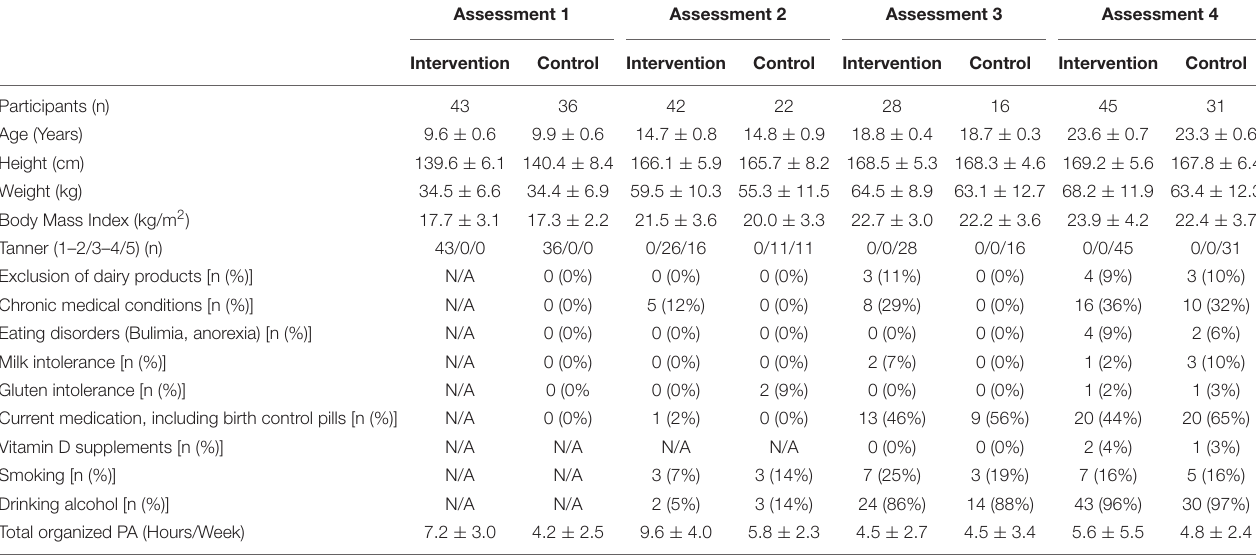
TABLE 2 | Anthropometry, pubertal development (Tanner stage), and lifestyle characteristics in the